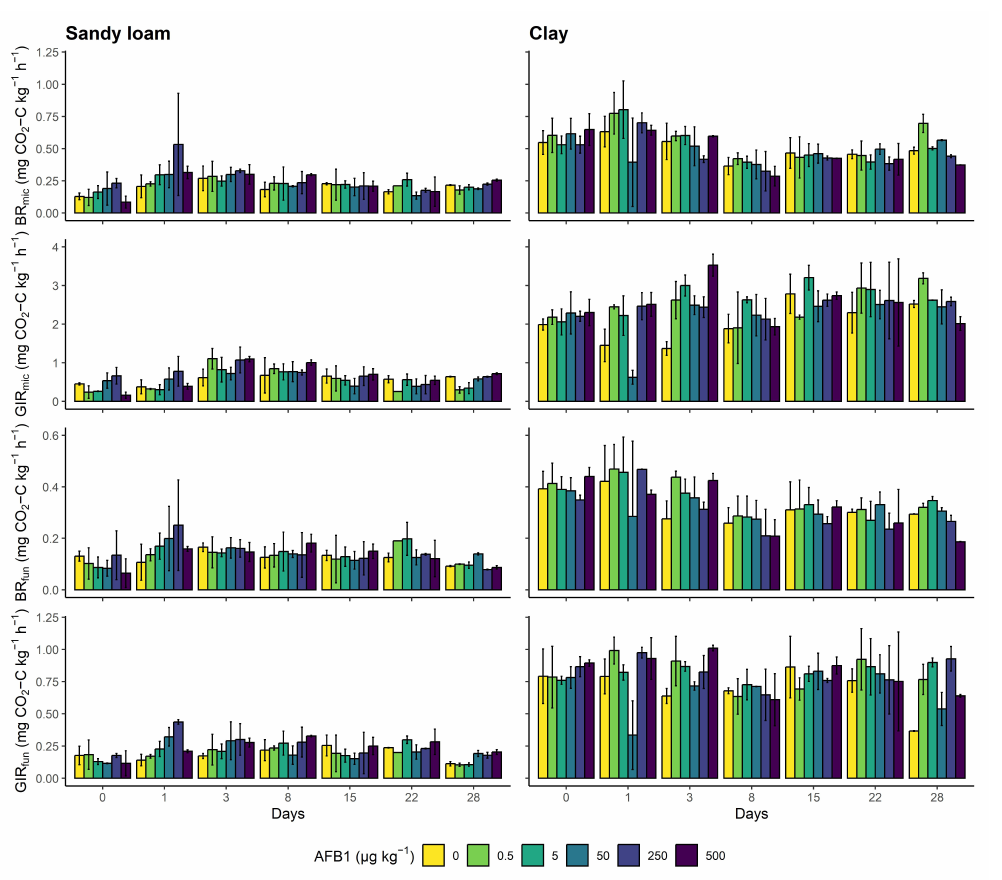
Figure A4. Microbial and fungal activities: Barplots showing mean values for microbial basal respiration (BR mic ), microbial glucose-induced respiration (GIR mic ), fungal basal respiration (BR fun ), and fungal glucose-induced respiration (GIR fun ). The error bars represent the standard deviations.